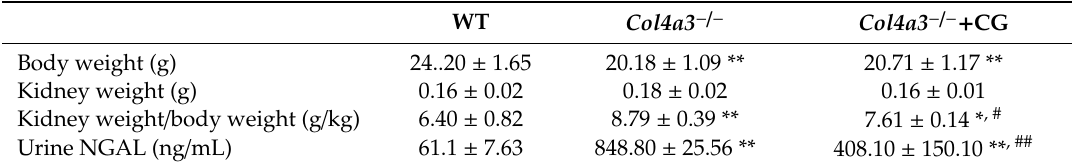
Table 1. E ff ect of CG200745 (CG) on the renal function in Col4a3 − / −